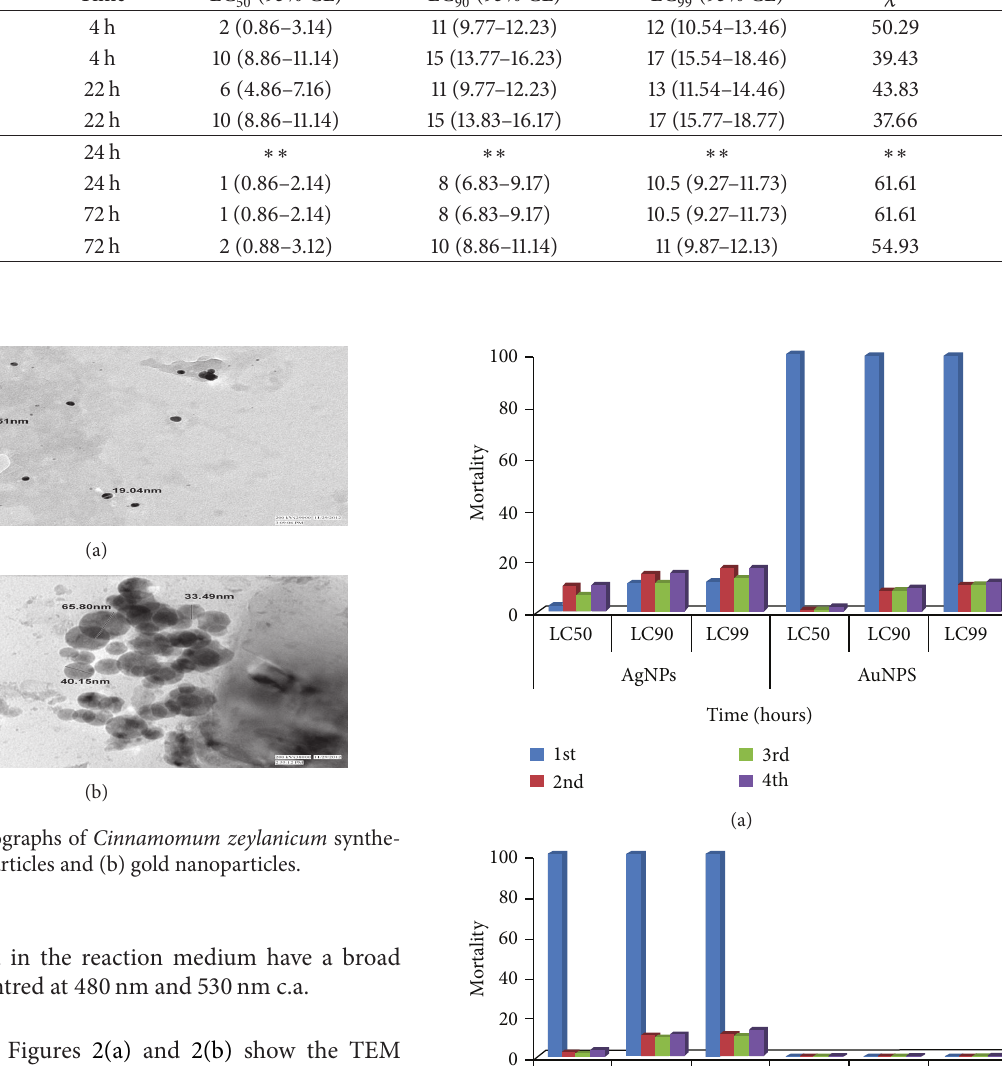
the 100% mortality after 24 h of exposure. The second instar larvae (LC 50 1, LC 90 8, and LC 99 10.5 ppm) after 24 h, third instar larvae (LC 50 1, LC 90 8, and LC 99 10.5 ppm), and fourth instar larvae (LC 50 2, LC 90 10, and LC 99 11 ppm) after 72 h of exposure were obtained with their confidence limits and 𝜒 2 and 𝑟 values (Table 1, Figure